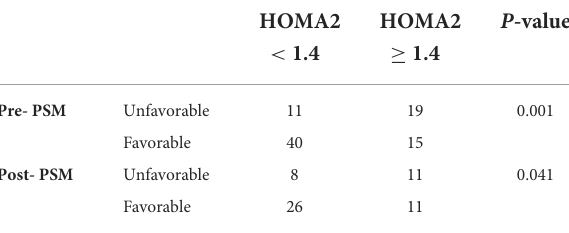
TABLE 3 Comparative analysis of Glasgow outcome scale (GOS) between the two groups before and after PSM.